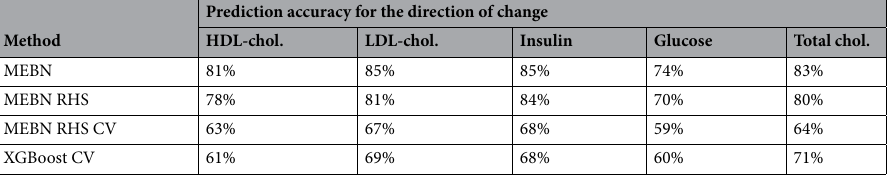
Table 2. Comparison of modeling methods. Comparison of modeling methods in a classification test where the direction of change for future concentration is predicted based on its past value and past diet. In-sample accuracy of mixed-effect Bayesian network (MEBN) assures that the found personal effects are real in this sample. The cross-validated (CV) accuracy is lower for out-of-sample observations but it is similar to the compared XGBoost decision tree